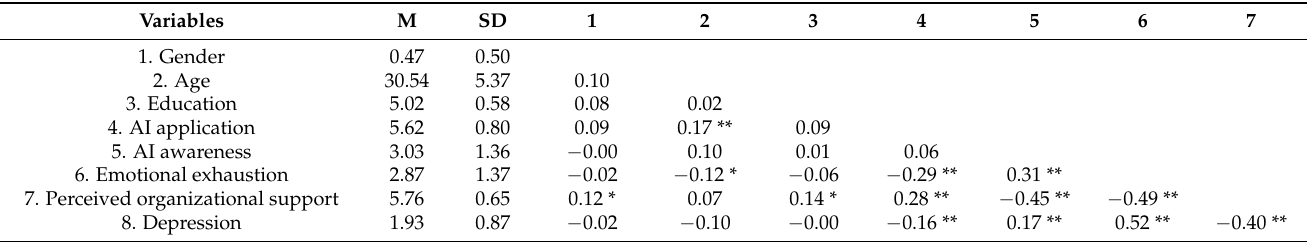
Table 2. Descriptive statistics of variables and correlation